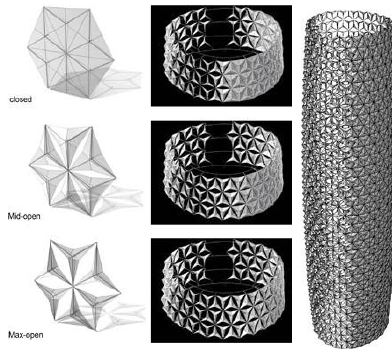
Figure 12. Al Bahar Towers external automated shading system, Abu Dhabi, UAE